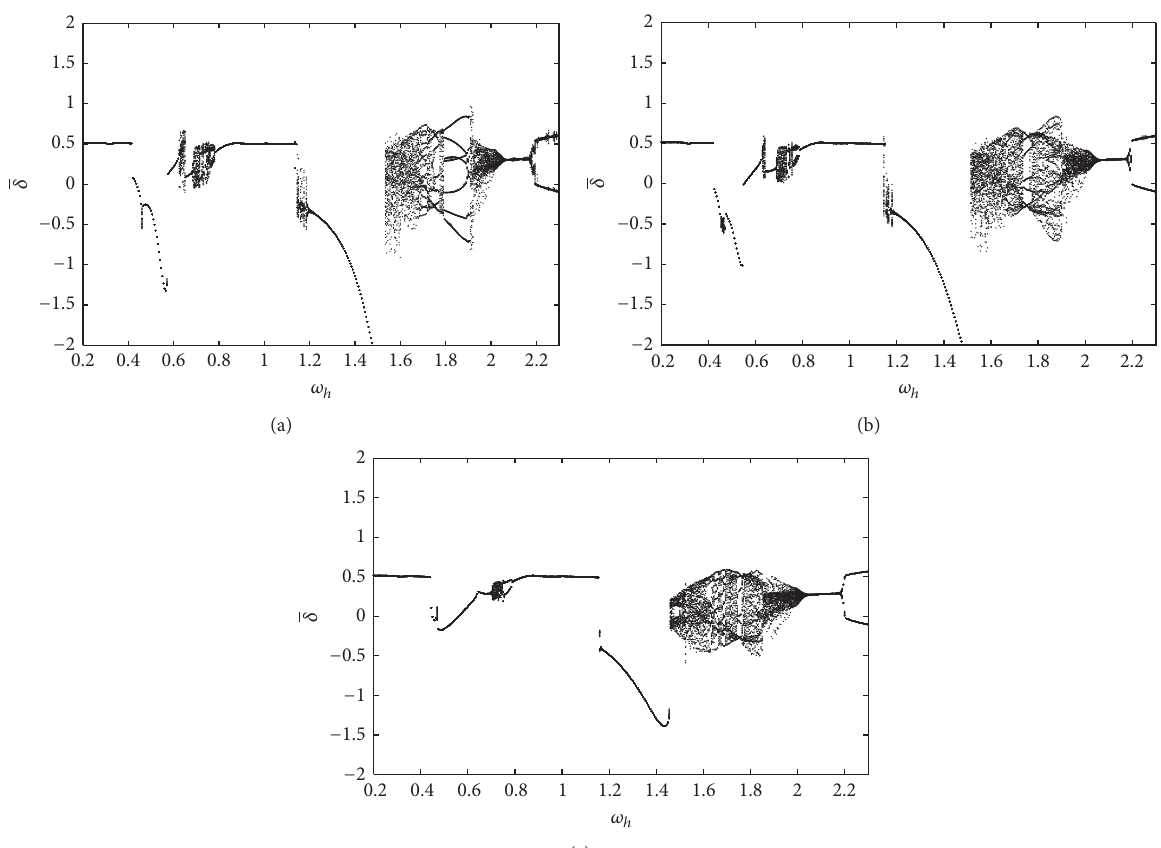
Figure 6: Bifurcation diagrams using 𝜁 as control parameter: (a) 𝜁 = 0.01 ; (b) 𝜁 = 0.04 ; (c) 𝜁 = 0.12 .